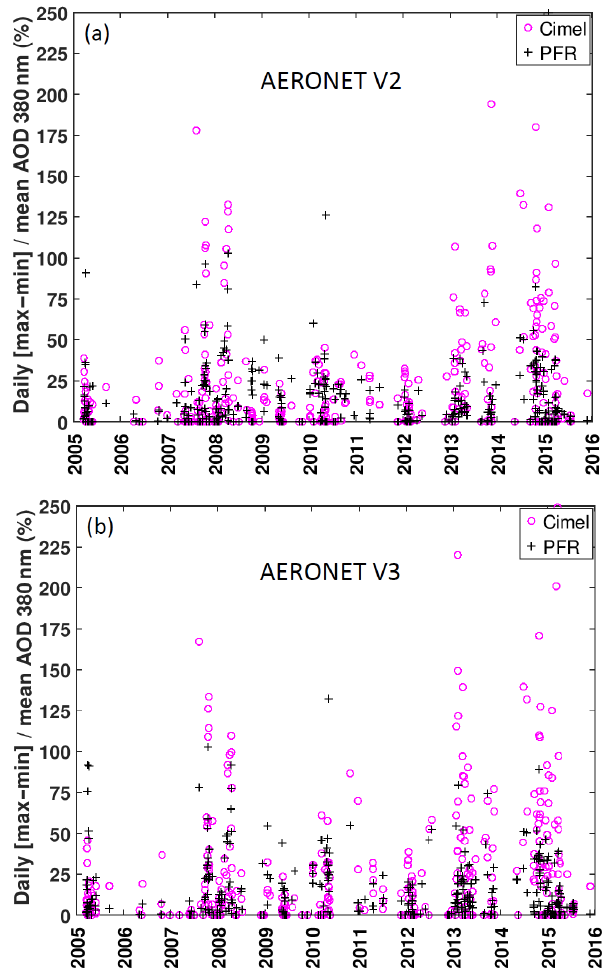
Figure 3. AOD diurnal range variation (maximum value mi- nus minimum value of AOD in 1d) at 380nm corresponding to AOD outliers (non-traceable AOD) under pristine conditions (AOD Cimel-500nm ≤ 0.03) in the period 2005–2015 for AERONET V2 (a) and V3 (b)